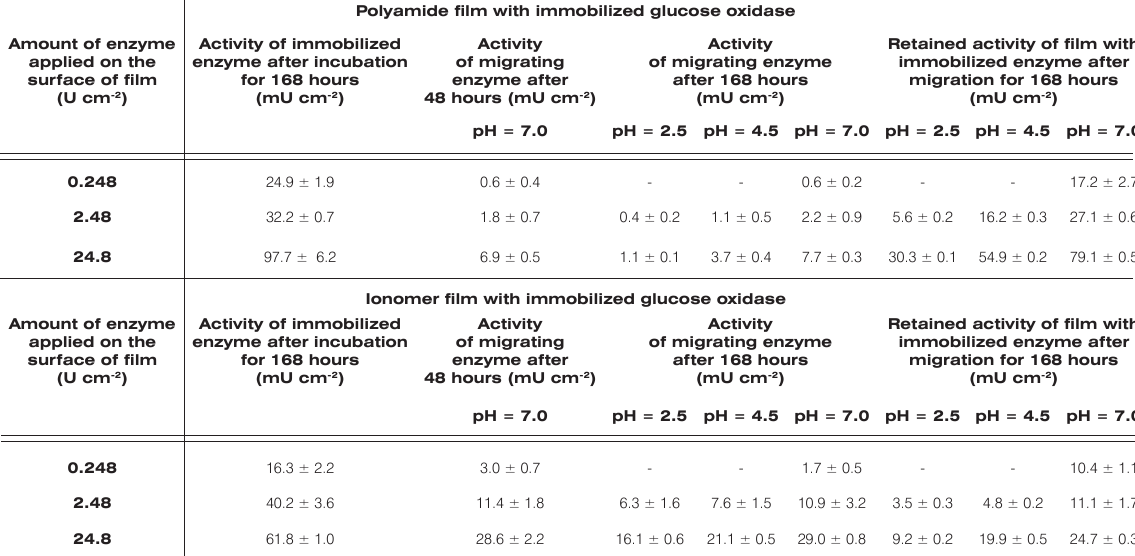
Polyamide film with immobilized glucose oxidase